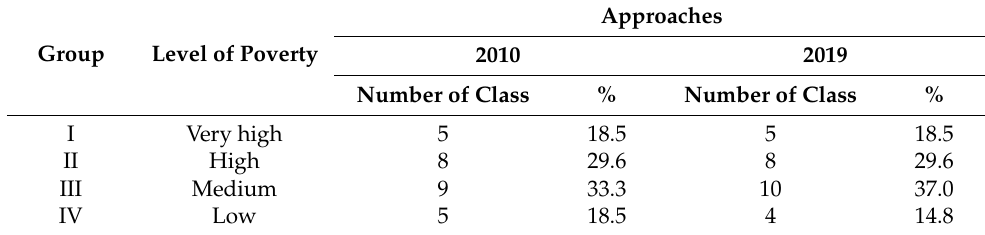
Table 4. Typological classification of EU countries in terms of poverty level in 2010 and 2019.